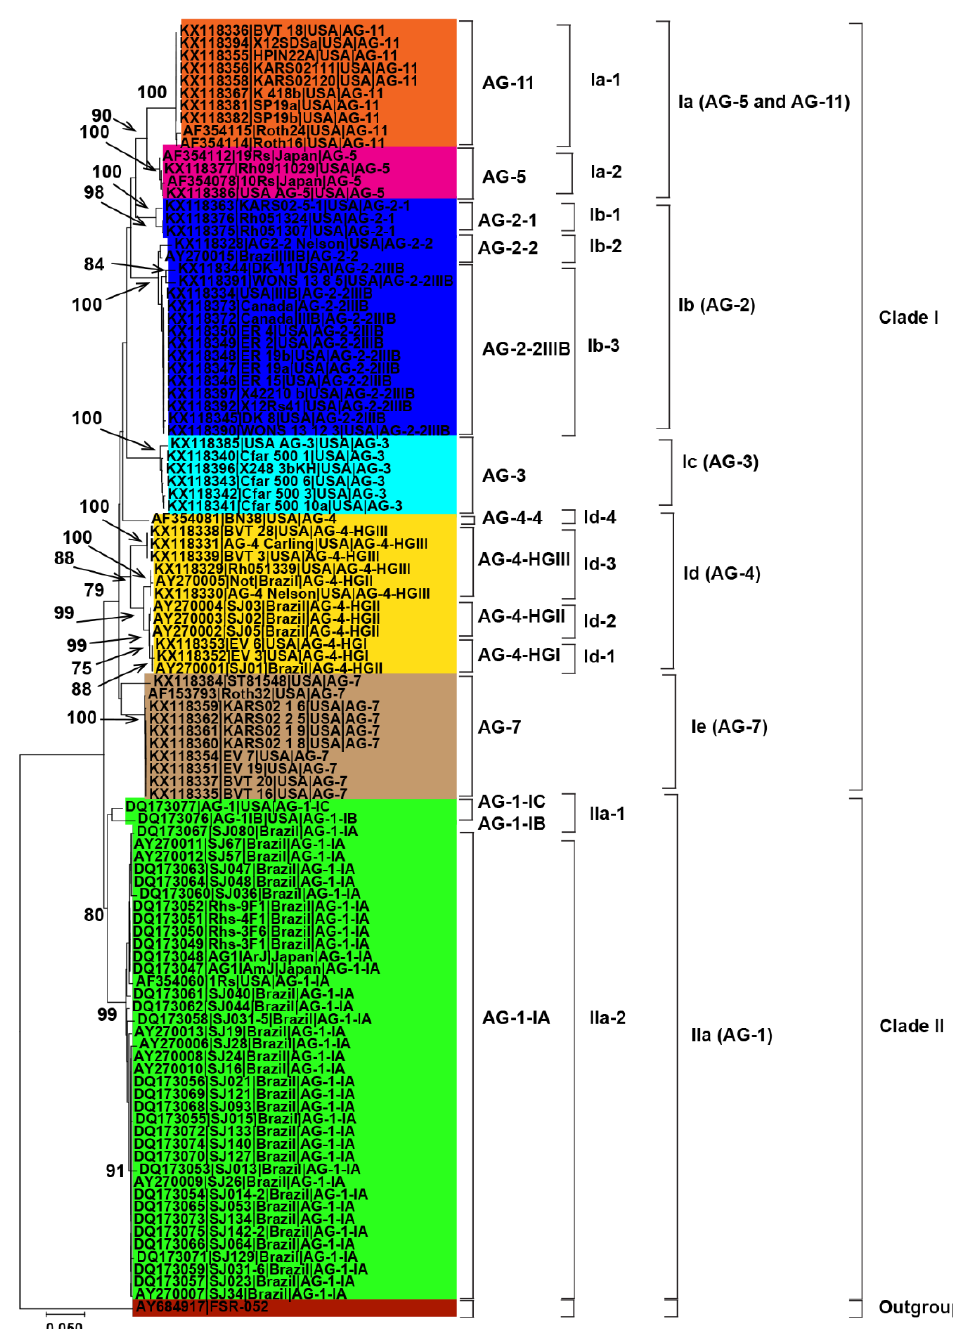
Figure 2. Genetic relatedness among the AG from soybean. Neighbor-Joining (NJ) analysis was used to build the trees. The accession numbers are followed by isolate, geographical origin and AG. Different colors show clades and/or subclades associated with AG. Thousands of replications were used to bootstrap tree branches. Numbers at nodes indicate bootstrap values, and only those ≥ 70 are shown. The outgroup, Athelia rolfsii FSR-052 (GenBank Accession No. AY684917), was used to root the tree. Scale bar indicates a genetic distance of 0.05 for horizontal branch length.